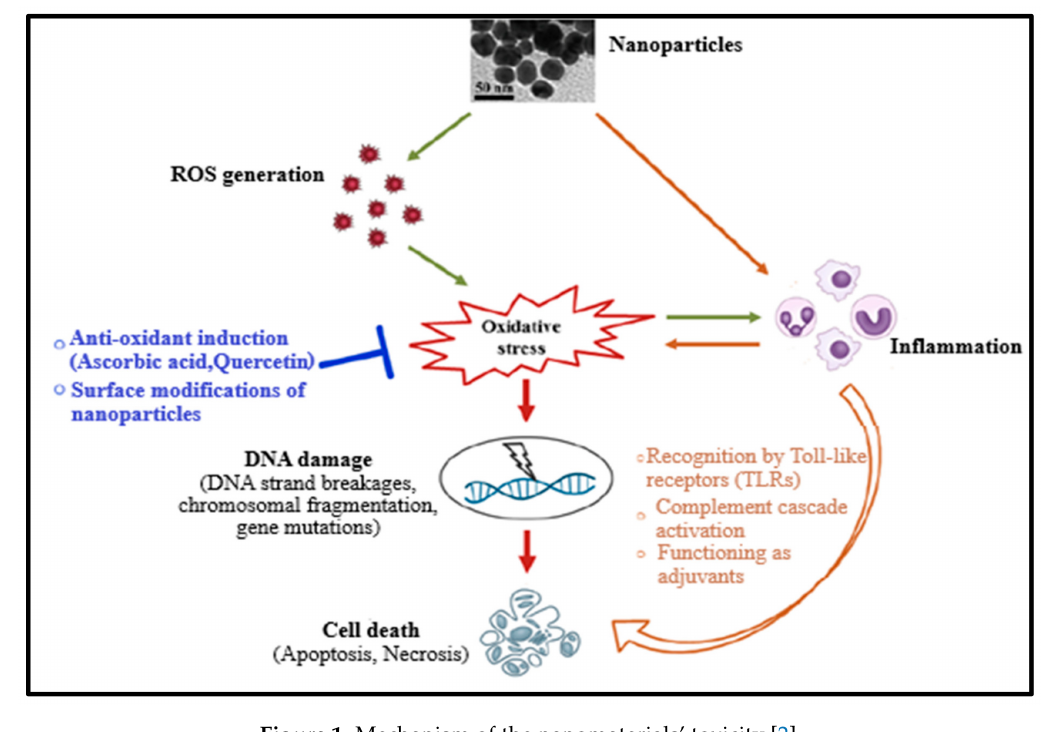
Figure 1. Mechanism of the nanomaterials’ toxicity [2].